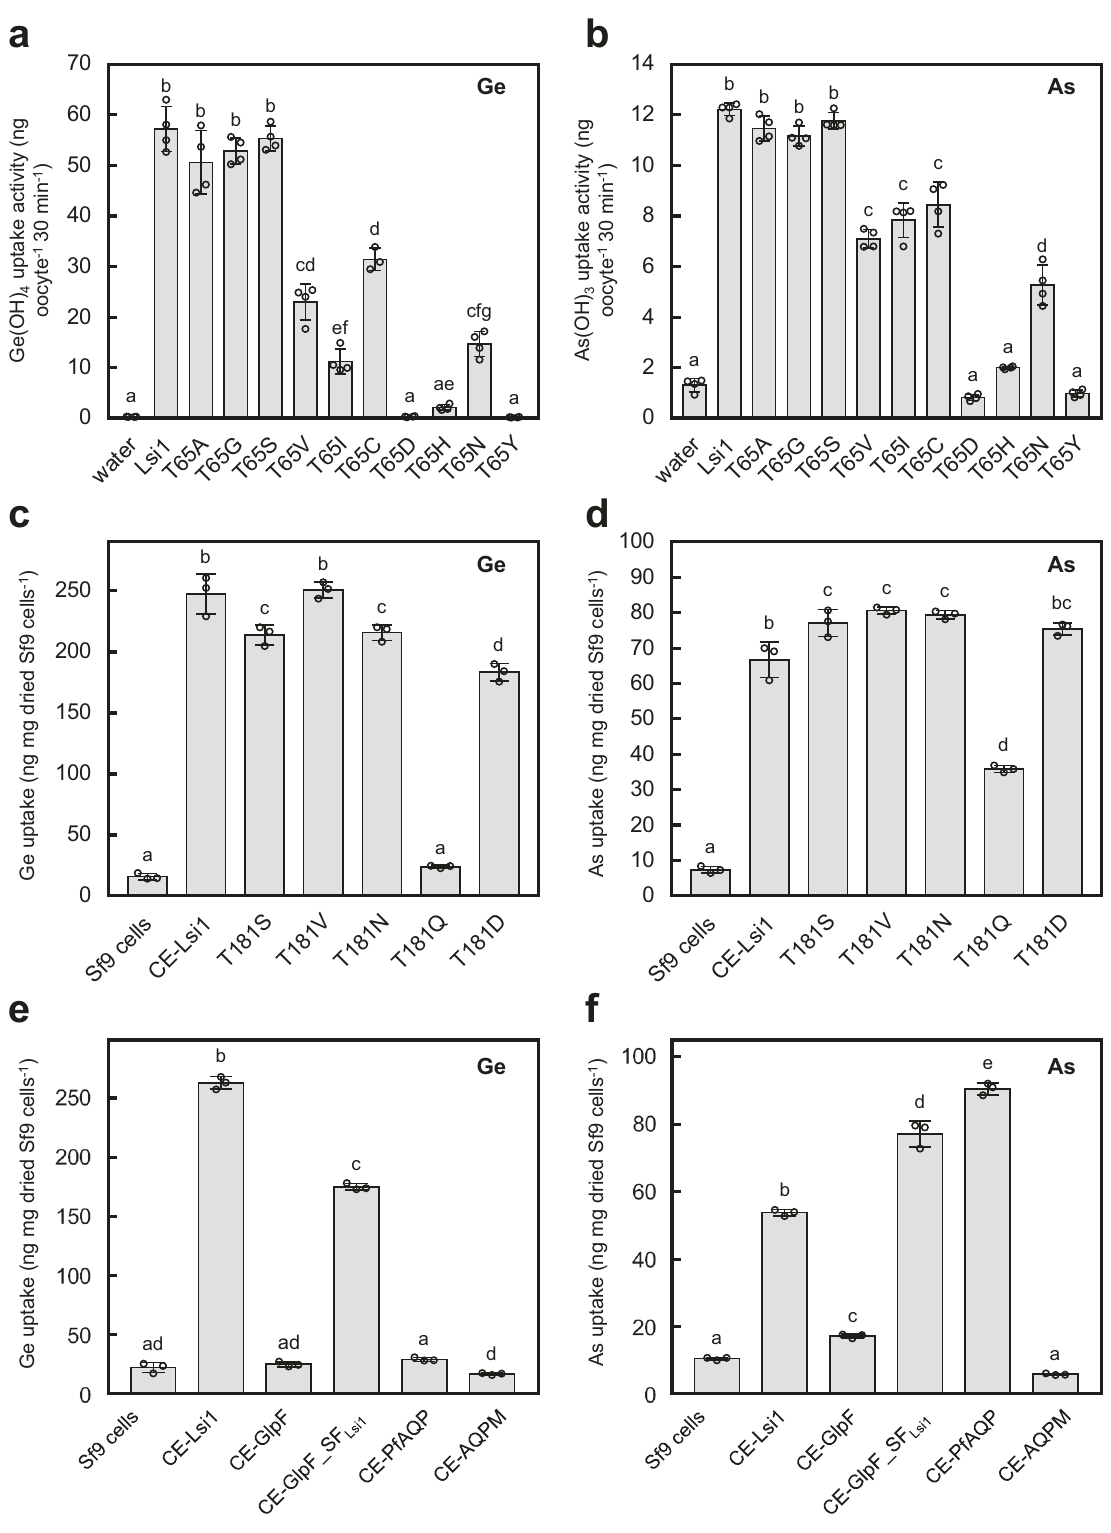
Fig. 5 Effect of Lsi1 mutation on the transport activity for Ge and As. Transport activity of germanic acid (Ge) ( a , Si analog) and arsenite (As) ( b ) in Xenopus oocytes. The oocytes were injected with water (as a control) or cRNA of Lsi1 WT or Thr65 TM1 mutants. Oocytes were exposed to a solution containing Ge or As for 30 min. Transport activity of Ge ( c , e ) and As ( d , f ) in Sf9 cells. C-terminally EGFP-tagged Lsi1 or Thr181 mutants ( c , d ) or other aquaglyceroporins ( e , f ) were expressed in the cells. The cells were exposed to a solution containing Ge or As for 5 min. In a − f , different letters above the columns indicate statistically signi fi cant differences at P < 0.01 by Tukey − Kramer ’ s test, and the test was two-sided. Values are means ± s.d., n = 3 for T65C in ( a ) and n = 4 for the others, n is independent